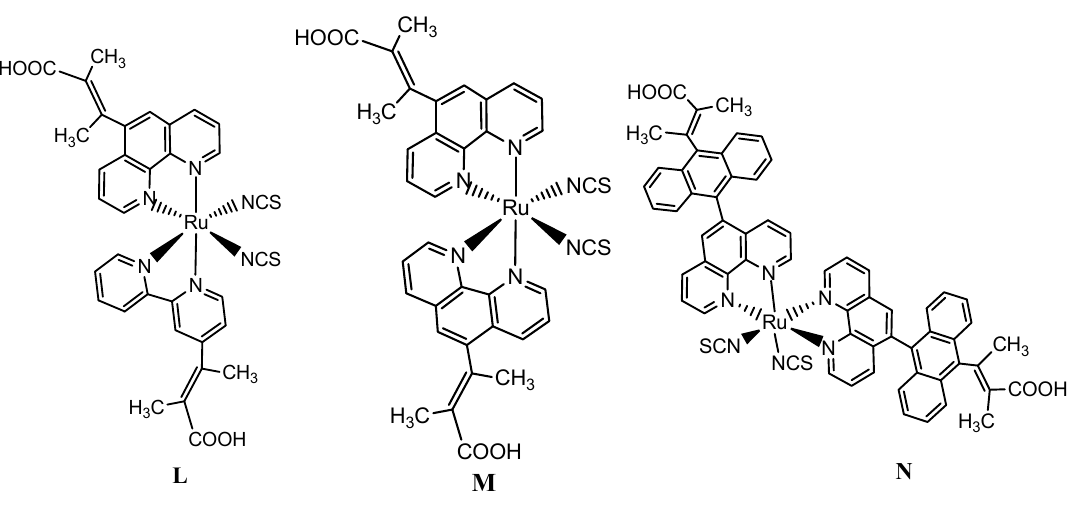
Figure 12. Representative structures of mixed ligand and/or heteroleptic ( L ) (NCS) ] 2+ [Ru(phen) n m 2